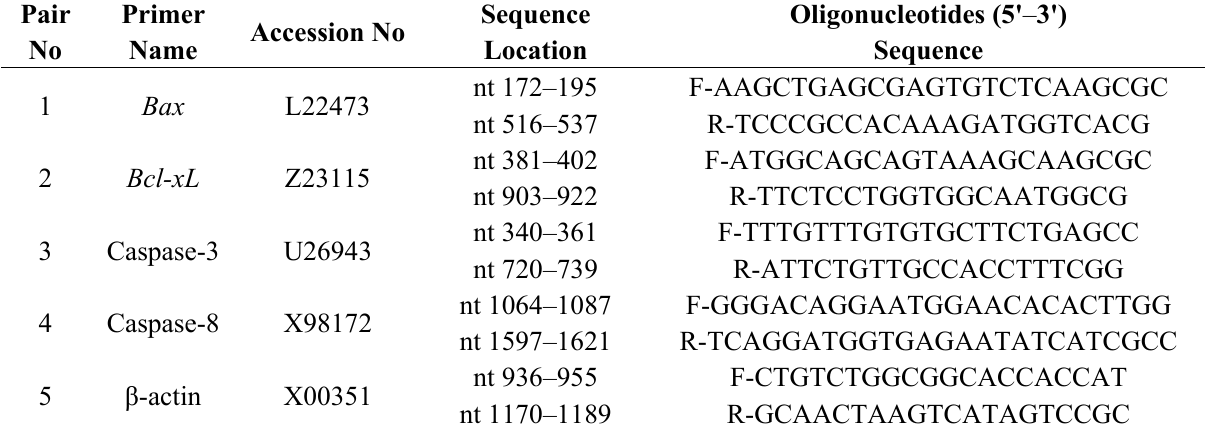
Table 1. Nucleotide sequence for PCR primers for amplification and sequence-specific detection of